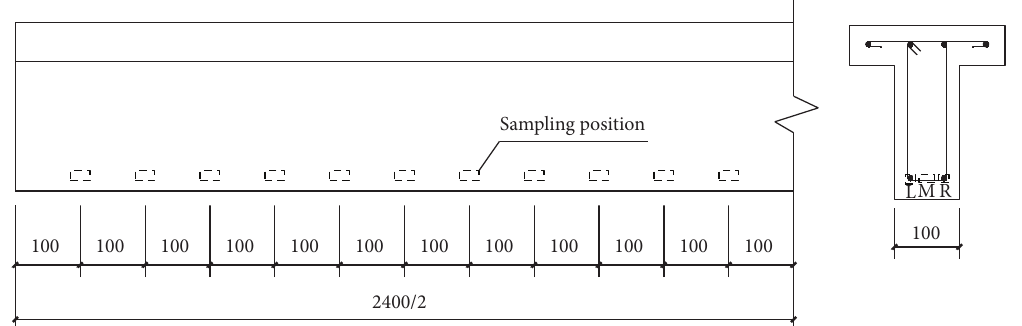
Figure 3: Sampling position (mm).